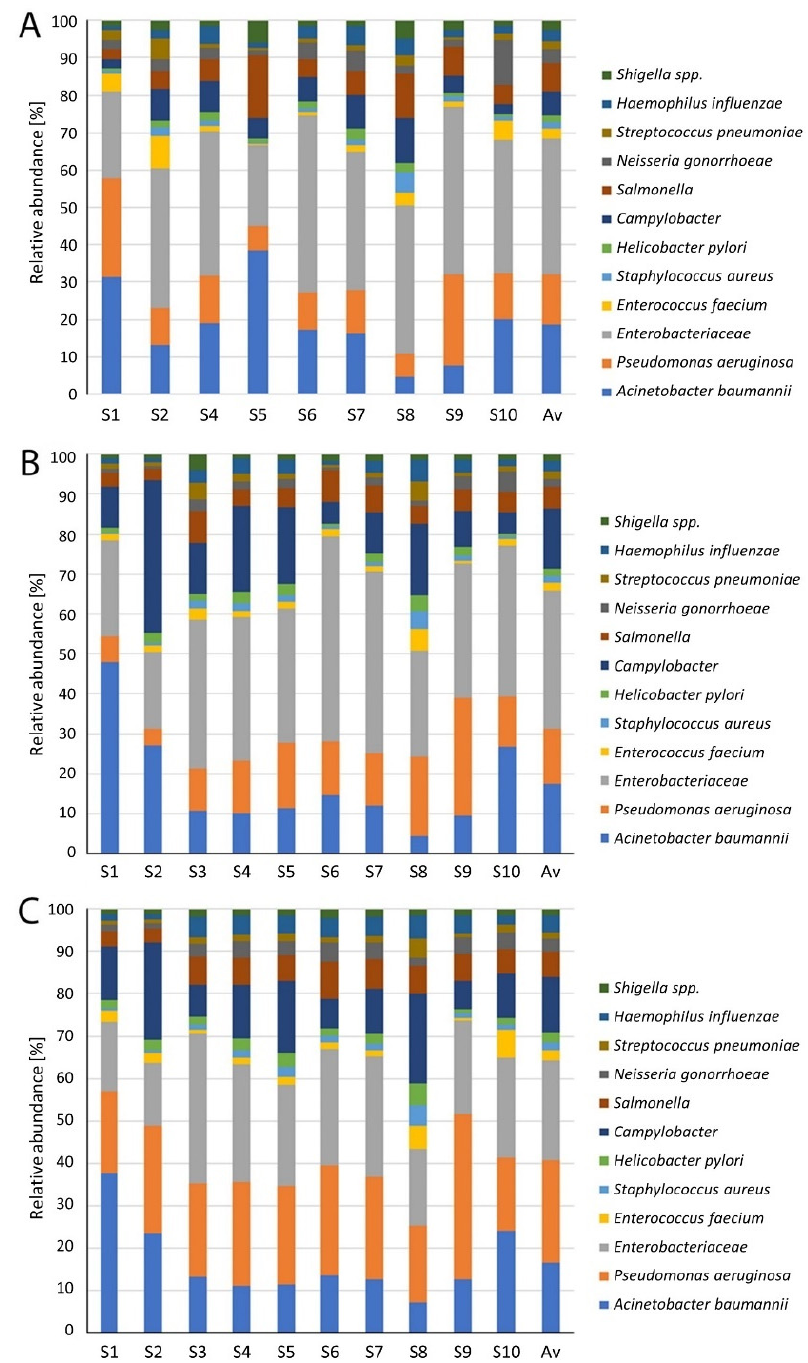
Figure 2. Technological and season changes of multi-antibiotic resistant pathogens from WHO list.